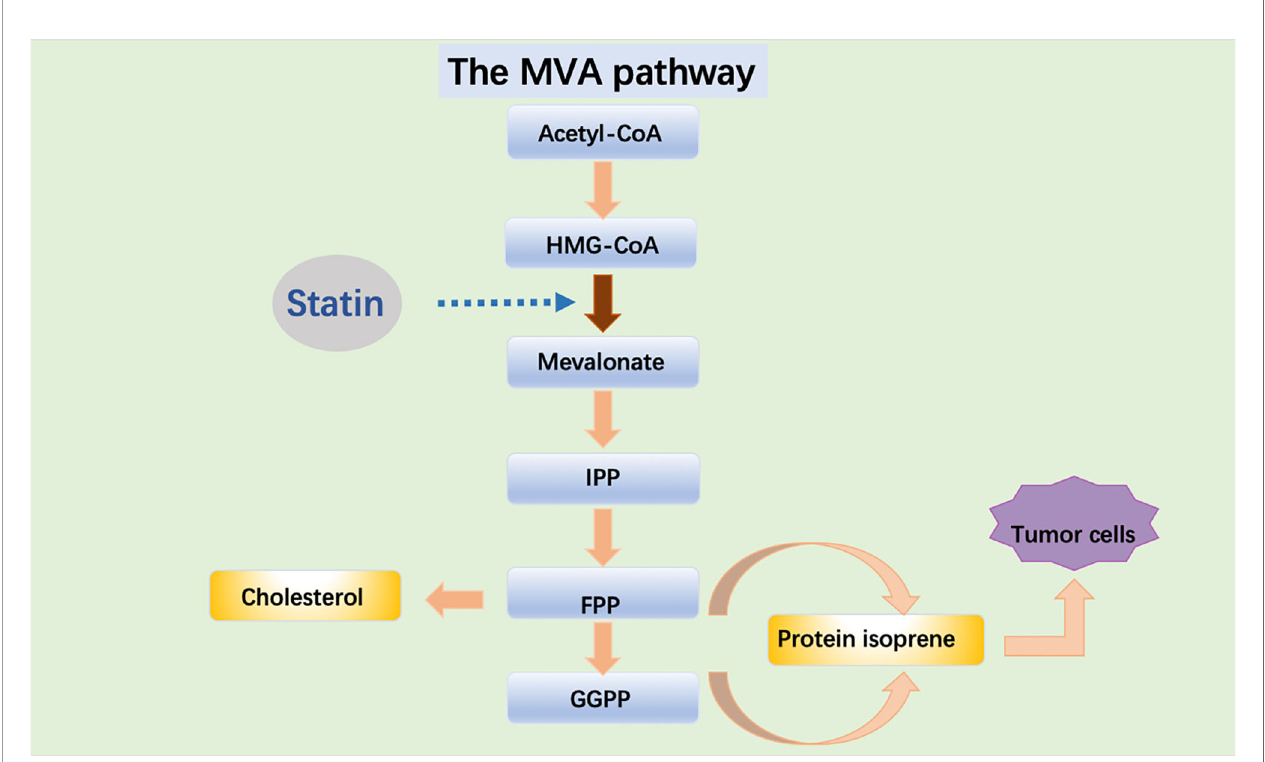
FIGURE 1 | Acetyl-CoA is transformed into HMG-CoA which is used by the enzyme HMGCR to synthesize MVA. MVA is further metabolized to farnesyl pyrophosphate (FPP), a precursor of cholesterol and sterols. FPP is also converted to geranylgeranyl pyrophosphate (GGPP), and these lipids are used for post- translational modi fi cation of proteins, including N-glycosylation and protein